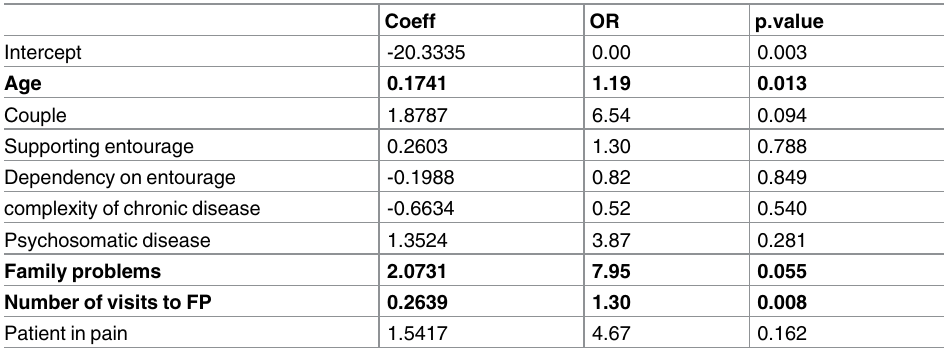
Table 3. Final regression